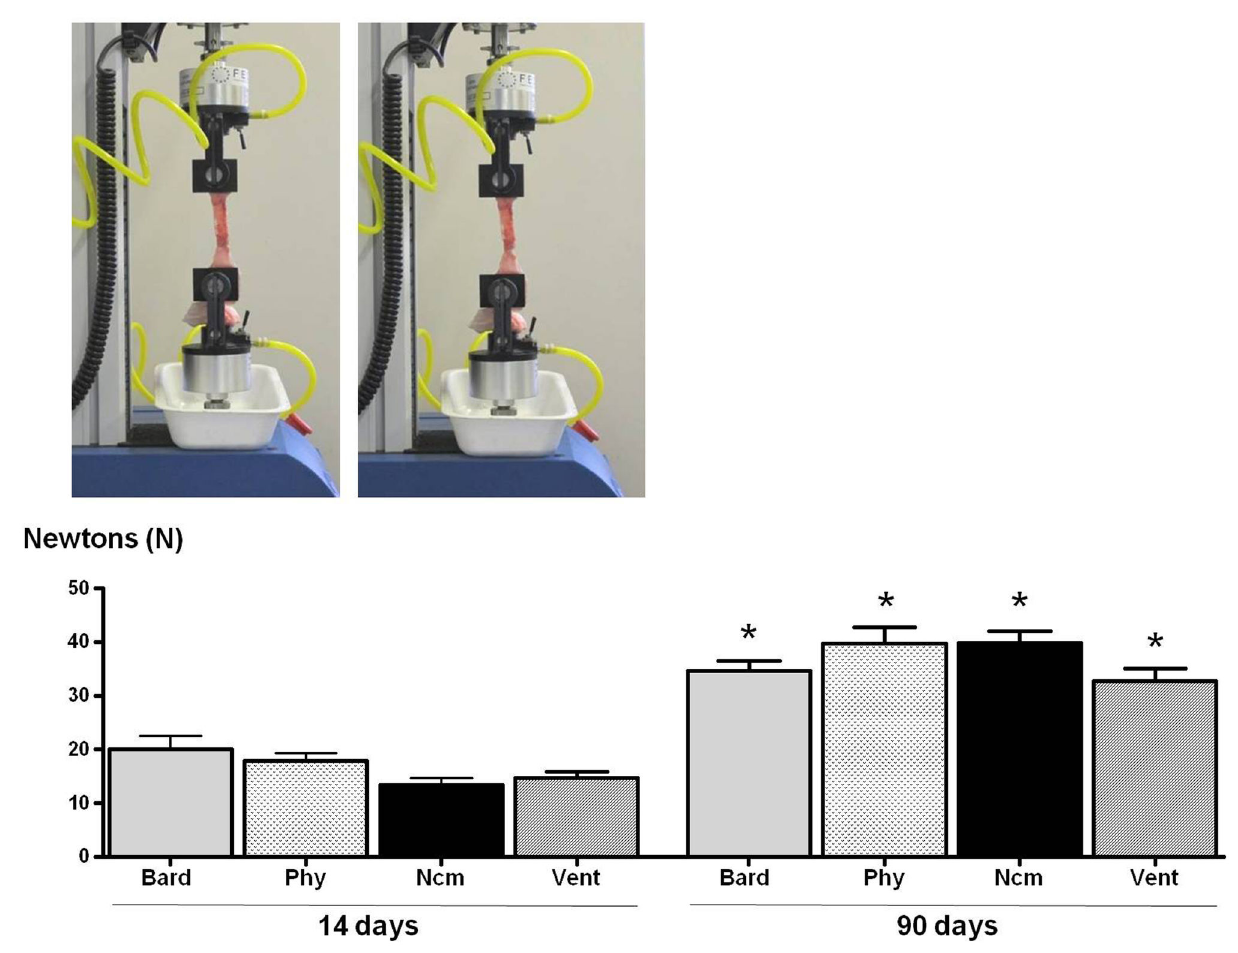
Figure 7. Biomechanical strength of the different meshes. Ultimate tensile strength of the different groups at 14 and 90 days postimplant. Bard mesh TM (Bard), Physiomesh TM (Phy), new composite mesh (NCM), Ventralight TM (VL). (*p<0.05 versus 14 days).